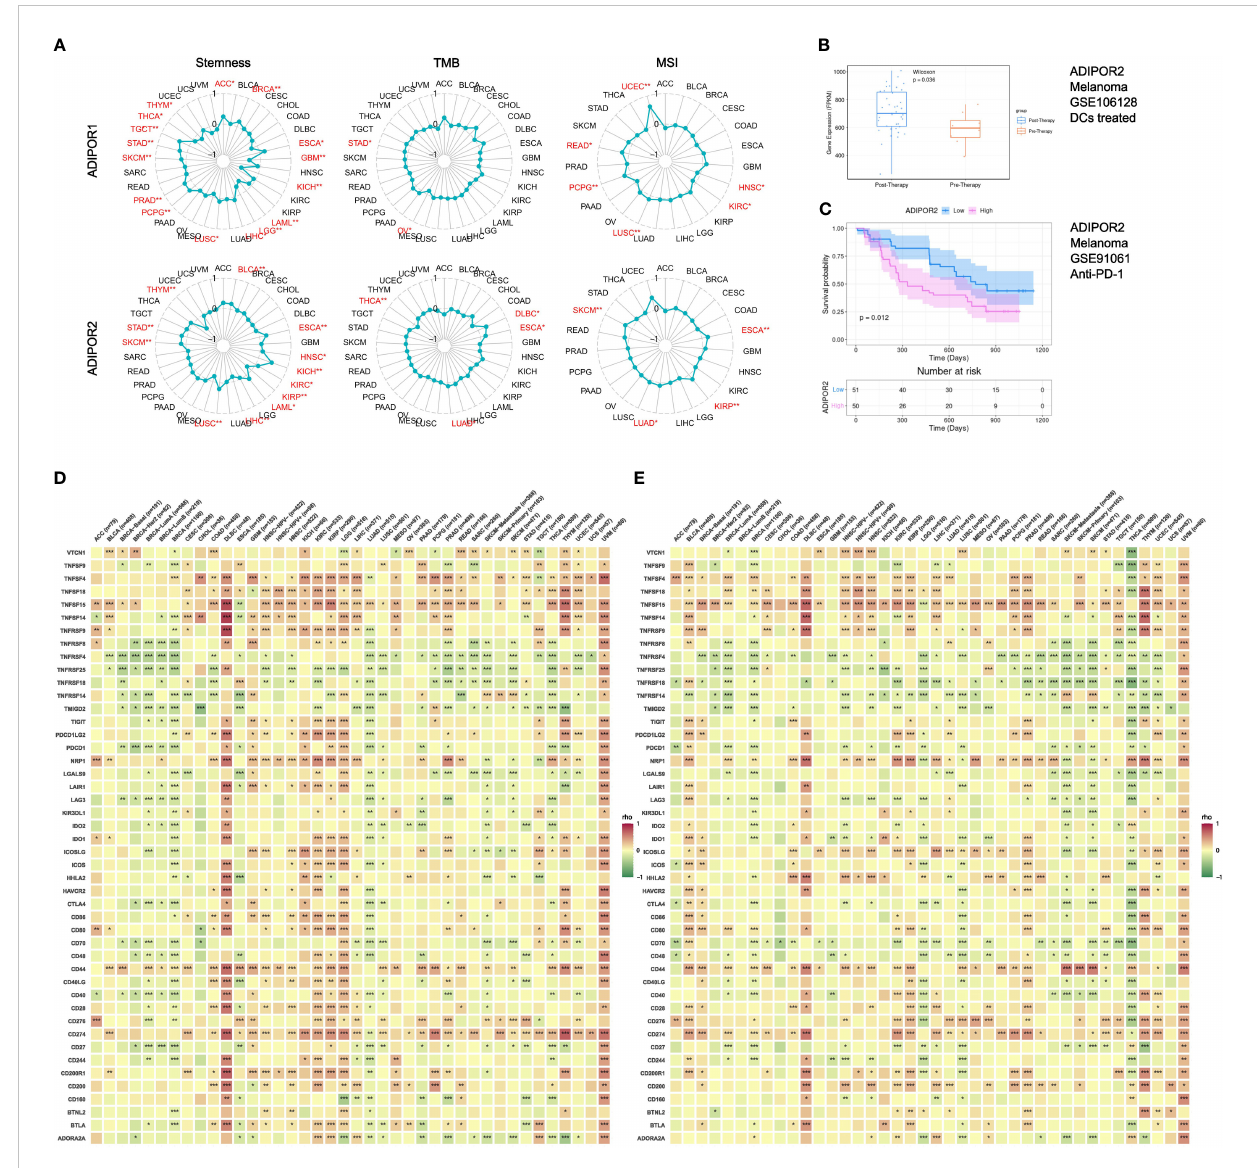
FIGURE 7 The correlation between ADIPOR1/2 and stemness, TMB, MSI, immunotherapy, and immune checkpoint genes. (A) The correlation between ADIPOR1/2 and stemness, TMB, and MSI across cancers. (B) The expression level of ADIPOR2 between Pre-Therapy and Post-Therapy. (C) The Kaplan-Meier plot of ADIPOR2 in immunotherapy cohort. (D, E) The correlation between ADIPOR1/2 and immune checkpoint genes. *P < 0.05, **P < 0.01, ***P <